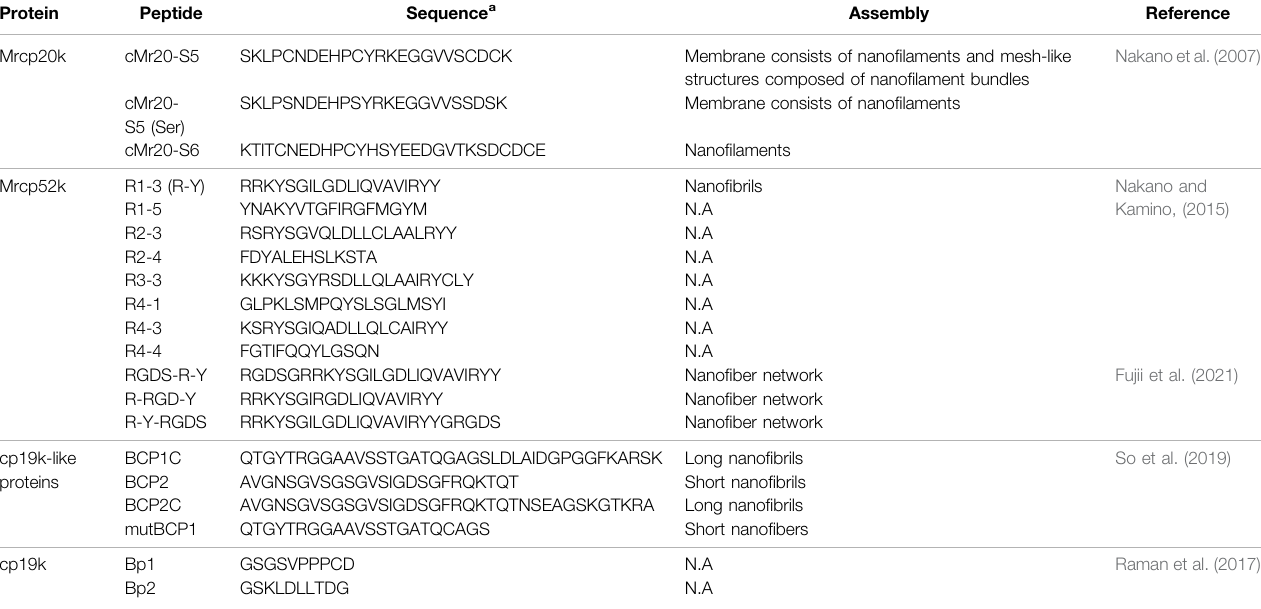
TABLE 1 | Summary of barnacle-inspired peptides.